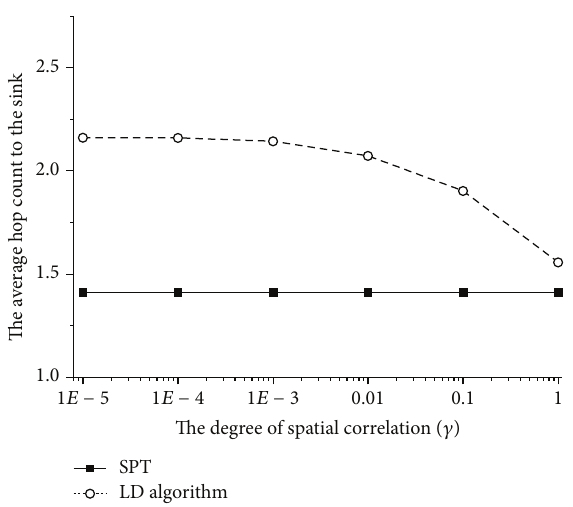
Figure 5: The average hop count from each sensor node to the sink node for different 𝛾